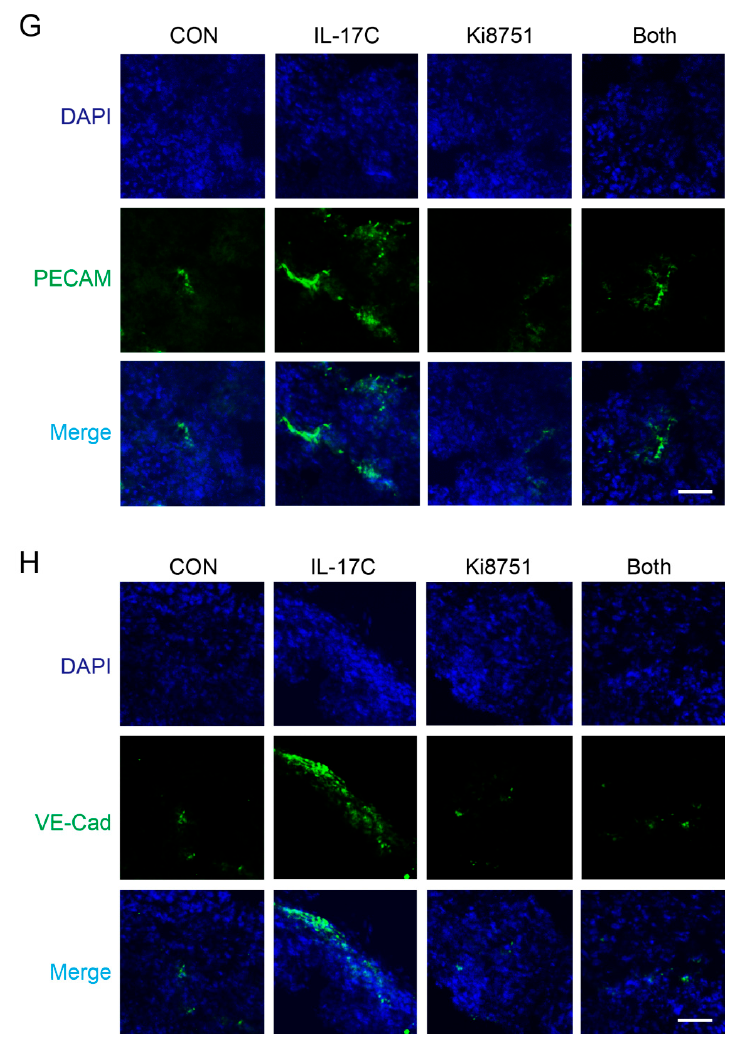
Figure 4. VEGFR2 inhibition suppresses IL-17C-induced tumor progression and angiogenesis in vivo. ( A – D ) A mouse xenograft experiment was conducted with treatment with IL-17C (1 μ g/tumor) and/or Ki8751 (10 μ g/tumor) by subcutaneous injection (CON, n = 10; IL-17C, n = 10; Ki8751, n = 10; Both, n = 9). Tumor volume was analyzed daily by using a caliper, and after euthanasia ( A ), and the representative photographs of the gross tumors in mice are shown ( B ). Tumor weight was also measured ( C ), and the photographs of the xenografts are shown ( D ). * p < 0.05 and *** p < 0.001 vs. the control group. # p < 0.05, and ## p < 0.01 vs. the IL-17C group. Error bars, SEM. ( E ) The protein levels of human VEGF in tumor tissues were analyzed using ELISA. ** p < 0.01 vs. the control group. Error bars, SEM. ( F ) Tumor tissue sections from each group were stained with H&E. Scale bar, 100 μ m. ( G , H ) Tumor tissue sections from each group were stained for FITC-labeled PECAM ( G ) and FITC-labeled VE-cad ( H ). DAPI staining was applied to identify nucleus. Scale bar, 50 μ m.